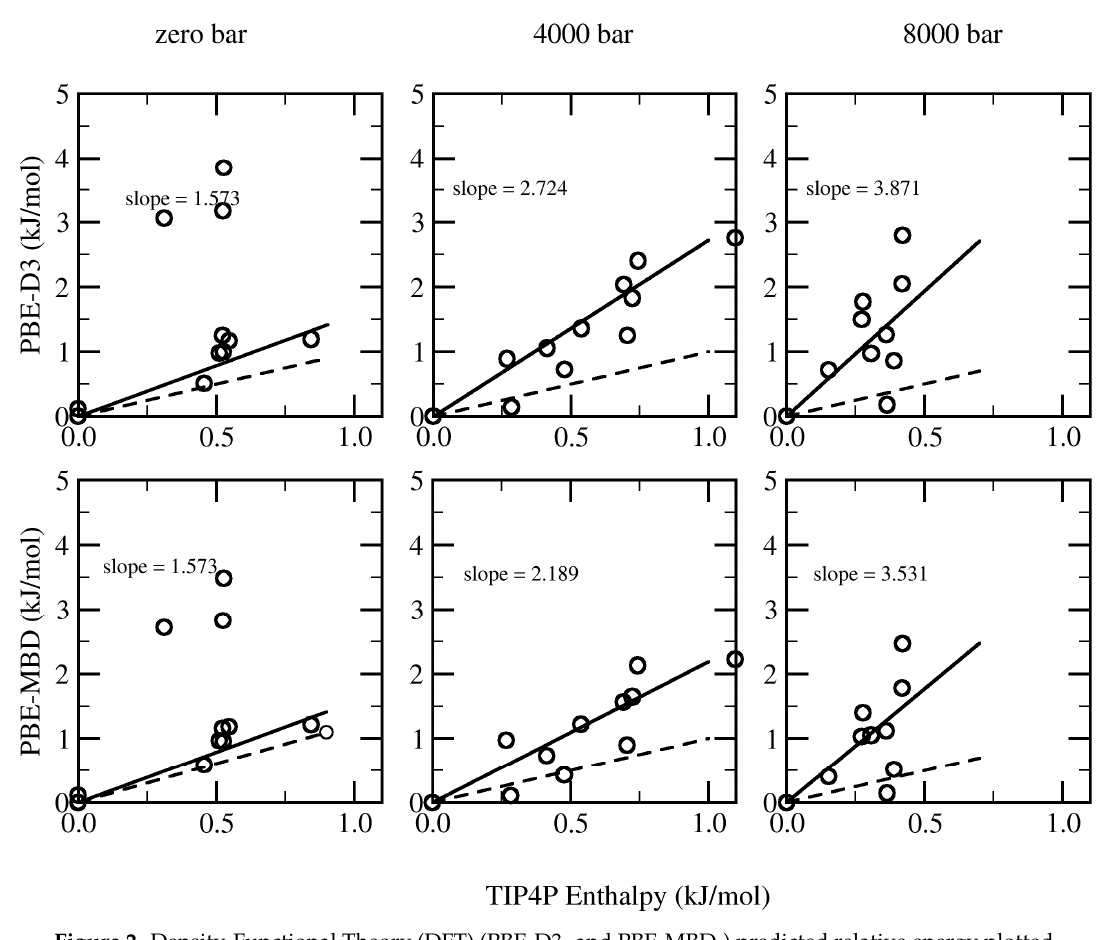
Figure 2. Density-Functional Theory (DFT) (PBE-D3- and PBE-MBD-) predicted relative energy plotted against that of the 4-site transferable interaction potential (TIP4P). The slopes of DFT (PBE-D3 and PBE-MBD) relative energy with respect to TIP4P relative energy are specified at 0 bar, 4000 bar and 8000 bar of external pressure, respectively. For visual comparison, the dash (—) line has a slope of unity, to represent perfect numerical TIP4P-DFT relative-energy agreement; the growing disparity with mounting pressure is clearly evident. Table 1. Comparison between TIP4P- and DFT-Predicted Ten Lowest-Relative-Enthalpy-per-Molecule Structures at 0